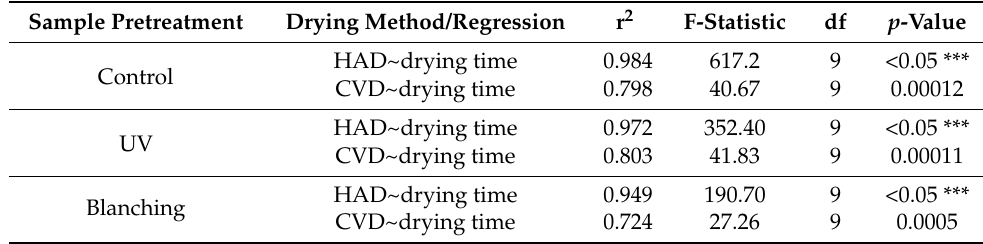
Table 1. Summary results of regression analysis for the effect of different pretreatment/drying methods on drying time of B. edulis